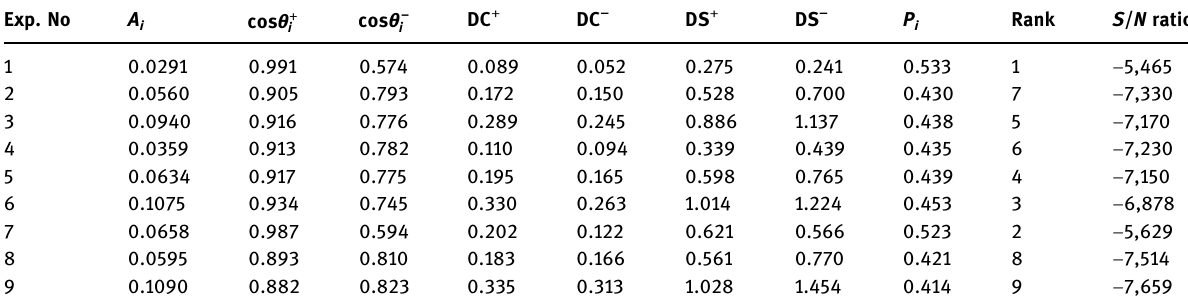
Table 3: Calculation results in Deng ’ s and S / N ratio values